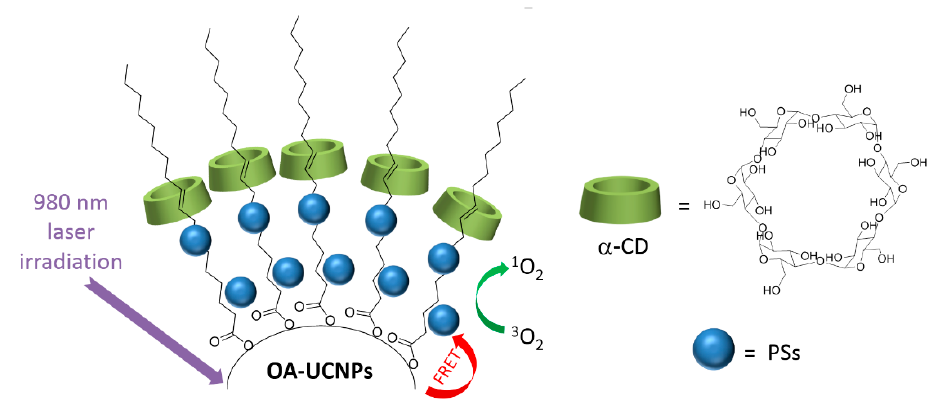
Figure 53. Schematic illustration of 980-nm near-infrared (NIR)-induced PDT using PS@ α -CD/oleic acid-capped NaYF 4 :Yb/Er up-converting nanoparticle (OA-UCNP) complexes. Adapted from Tian; Ren; Yan; Jian; Gu; Zhou; Jin; Yin; Li; Zhao [73].